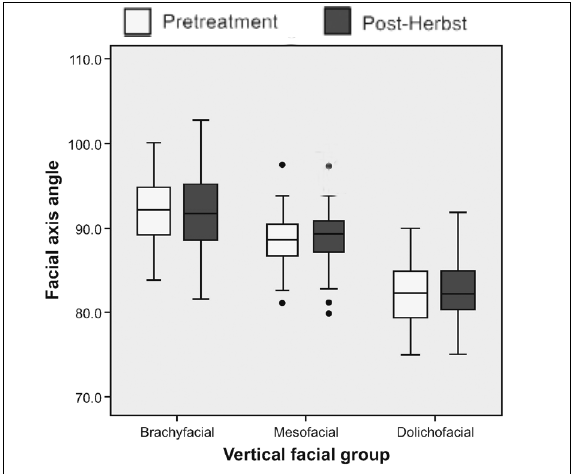
Figure 2. Pretreatment and post-Herbst distances from Pog’ to Pog for the three vertical facial groups.